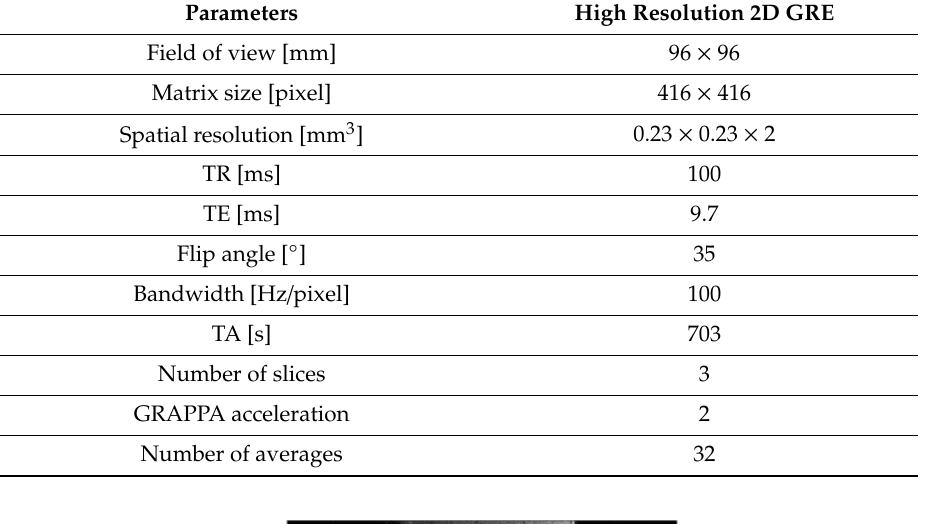
Table 2. 2D GRE sequence parameters used for High Resolution imaging.